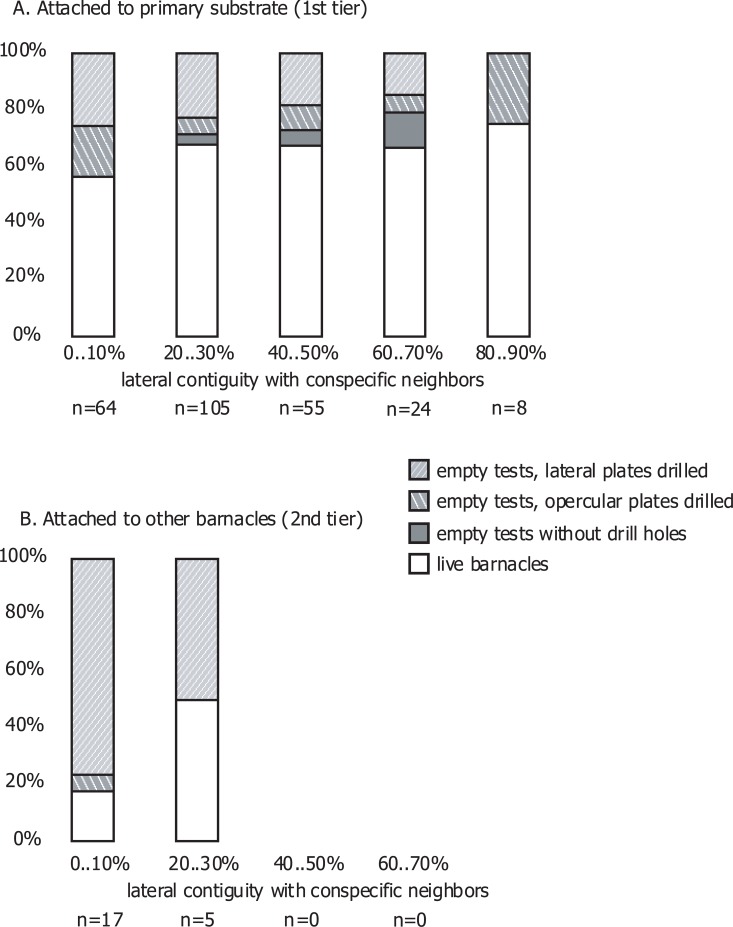
Differential survival of barnacles in predator enclosure cages.Survival of adult barnacles by tier and lateral contiguity with conspecific neighbors. Pooled data for 6 whelk enclosure cages.